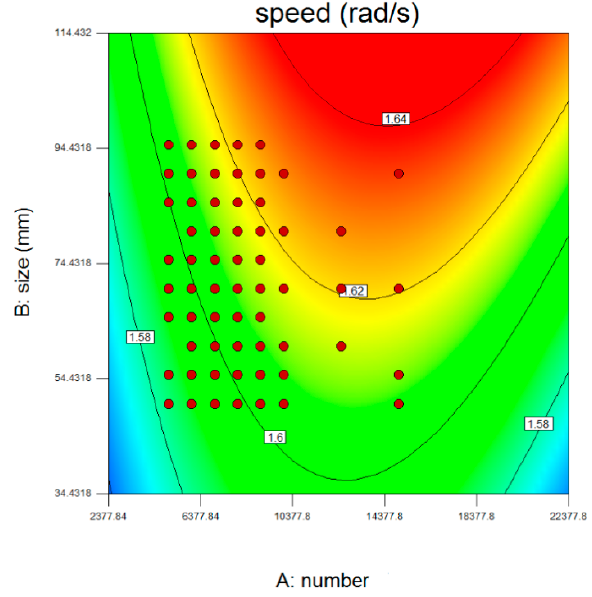
Figure 9. The contour map of the response surface.